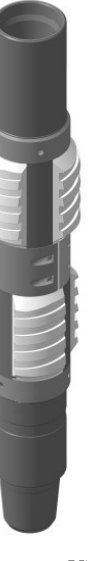
Figure 1. View of a mechanical scraper.